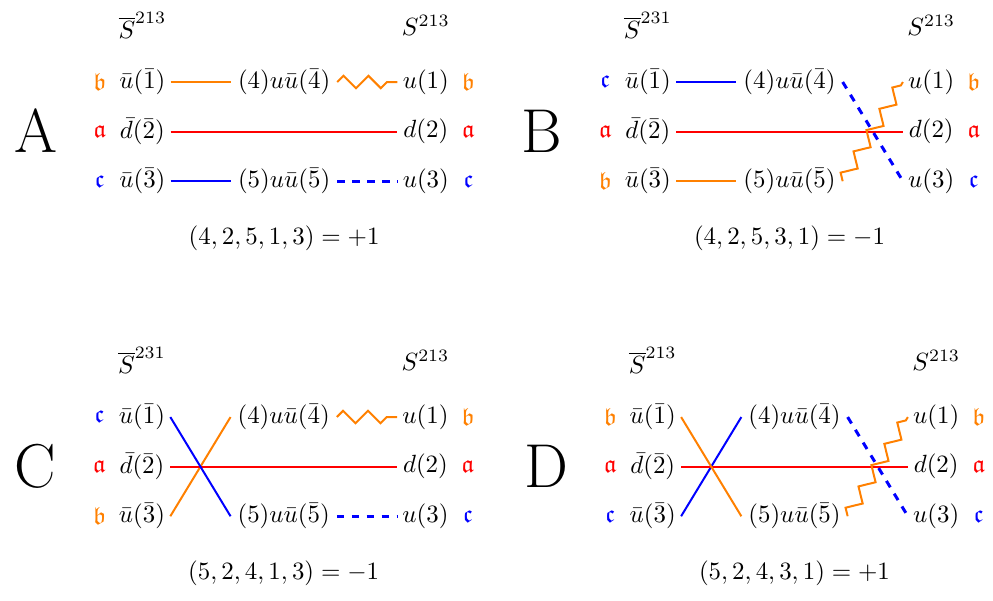
( y ) O uu (0) with C topology 1 i j